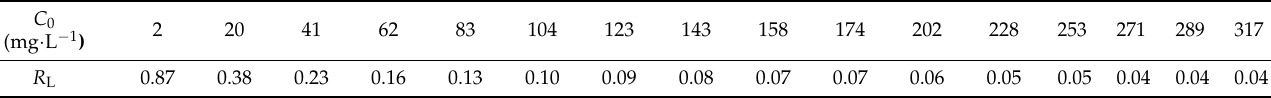
Table 2. Effect of the initial dye concentration C 0 on the infinite dispersion constant R L.